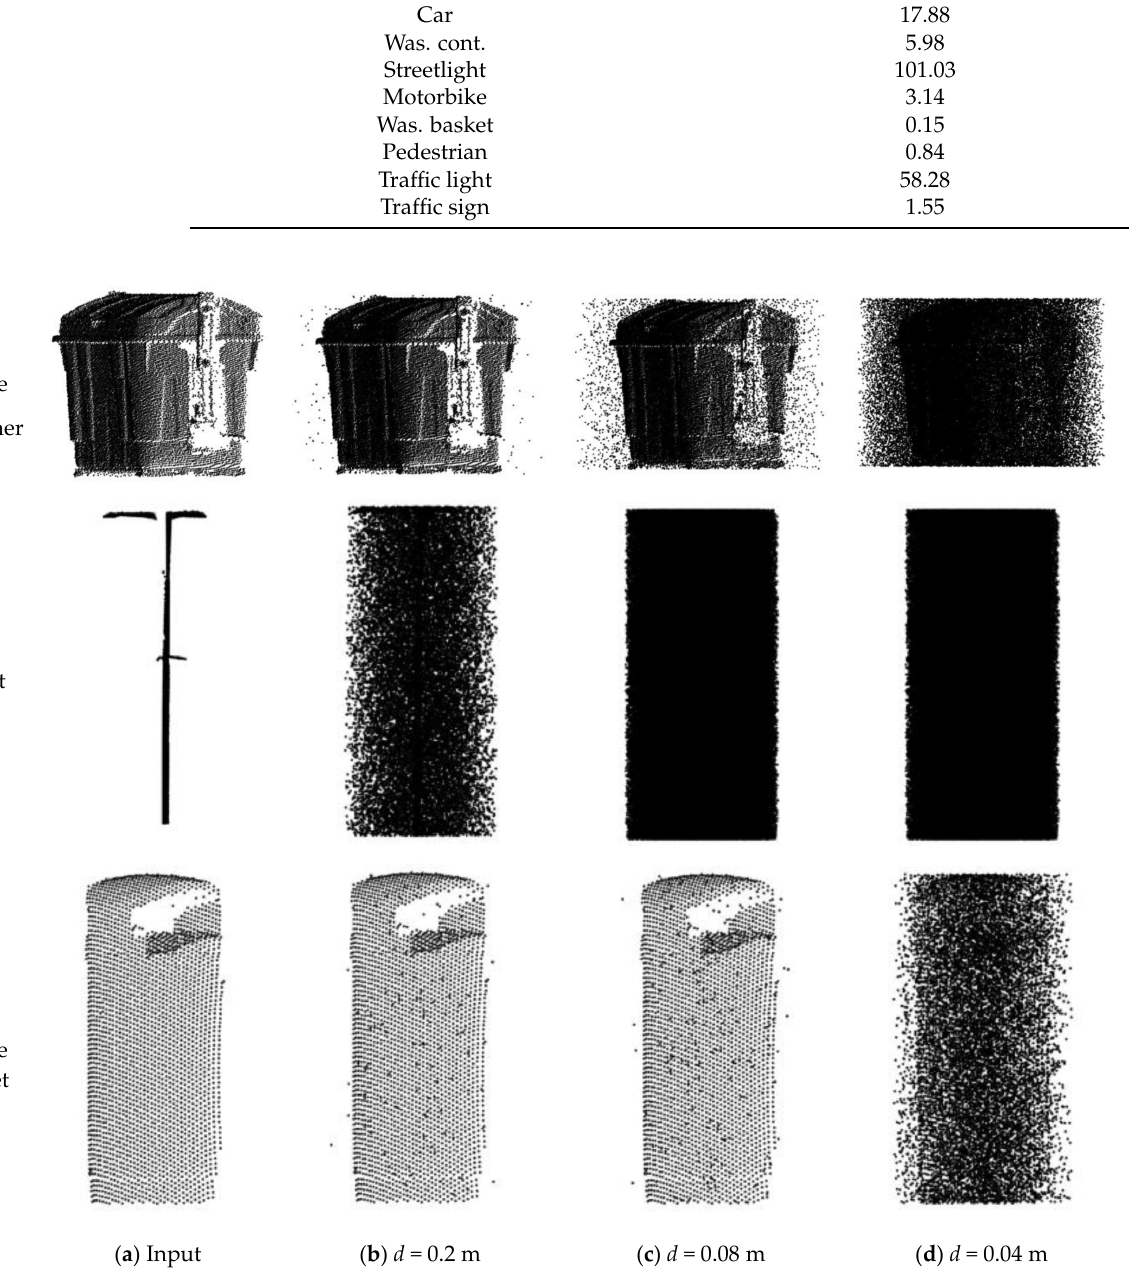
Figure 6. Images generated from point cloud objects at different levels of noise.